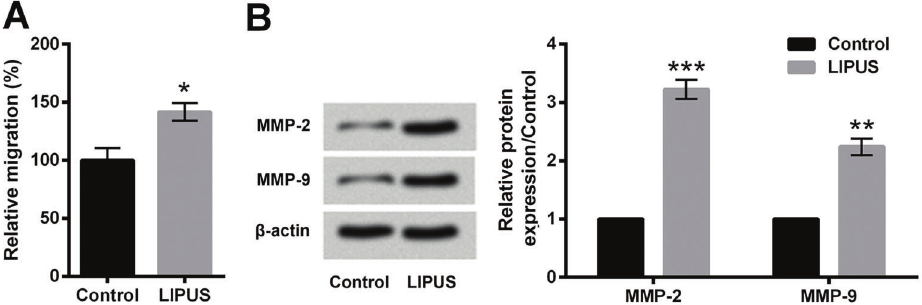
Figure 2. Low-intensity pulsed ultrasound (LIPUS) promoted migration of HaCaT cells. HaCaT cells were exposed to LIPUS, and unstimulated cells acted as control. A , Relative migration was determined by Transwell assay. B , Expression of proteins associated with migration was evaluated by western blot analysis. Data are reported as means ± SD of three independent experiments. *P o 0.05, **P o 0.01, ***P o 0.001 compared to control (Student ’ s t -test).